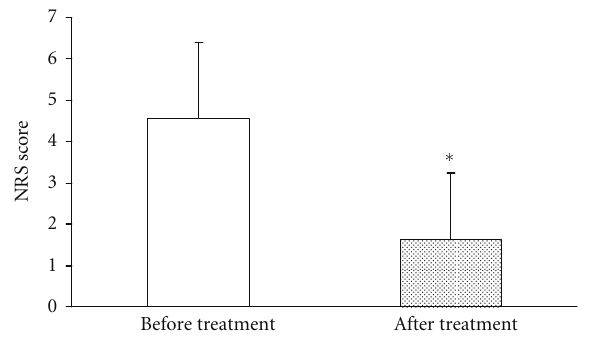
Figure 7: The NRS scores before and after treatment. Expression values are the mean and standard deviation, and the di ff erence between groups was analyzed using Wilcoxon Signed-Rank Test. Asterisk means that this group has statistical di ff erence with control group ( P < 0 .